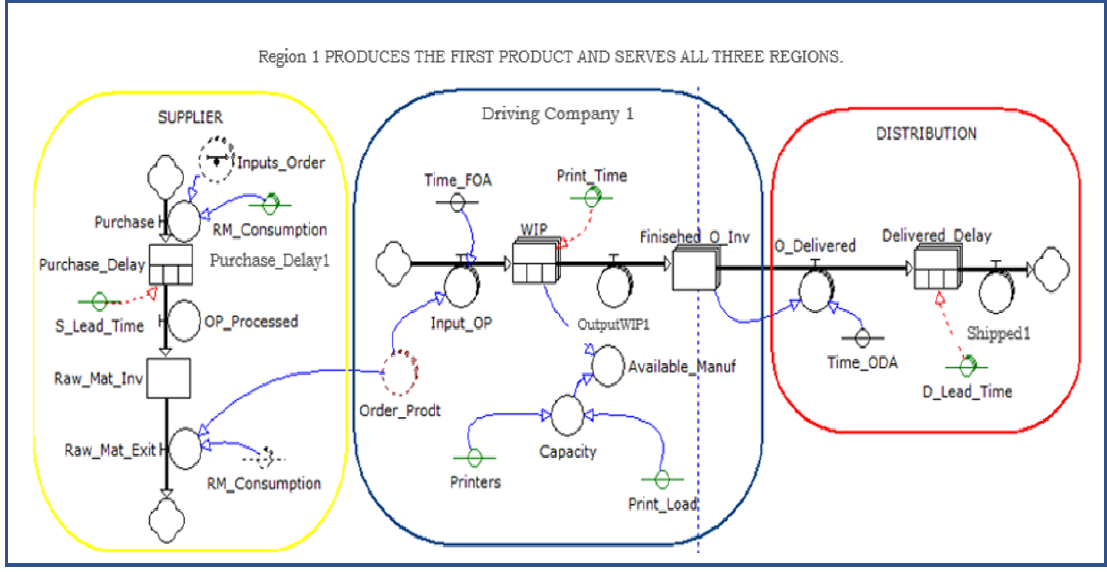
Figure 8. Operation in region 1 — scenario 1: own elaboration. Evolution software.